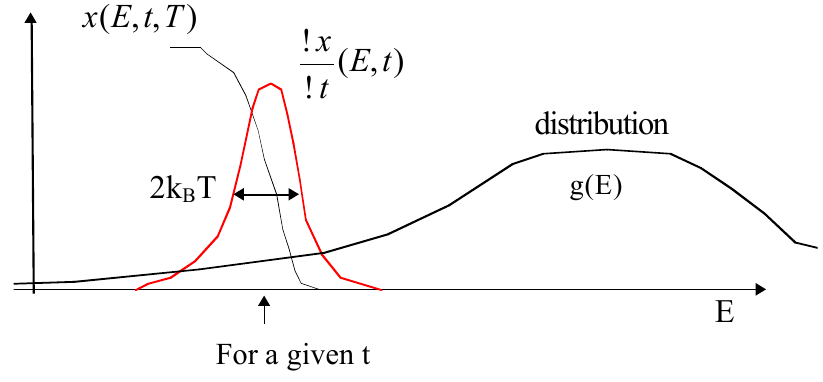
Figure 21. Comparison of widths between x ( E , t , T ) and the distribution g ( E